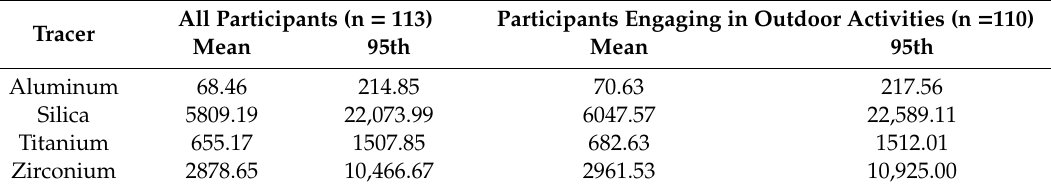
Table 10. Estimation of soil and dust ingestion (mg / day) based on outdoor activities.